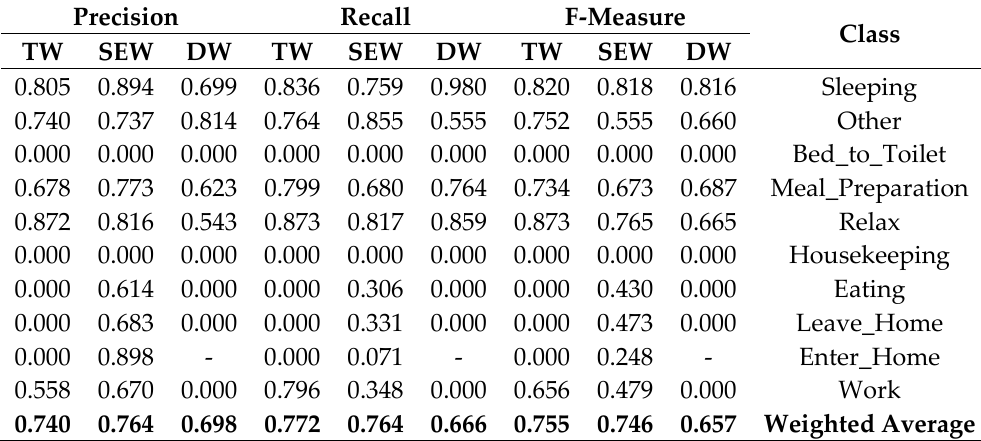
Table 2. Results for each of the windowing